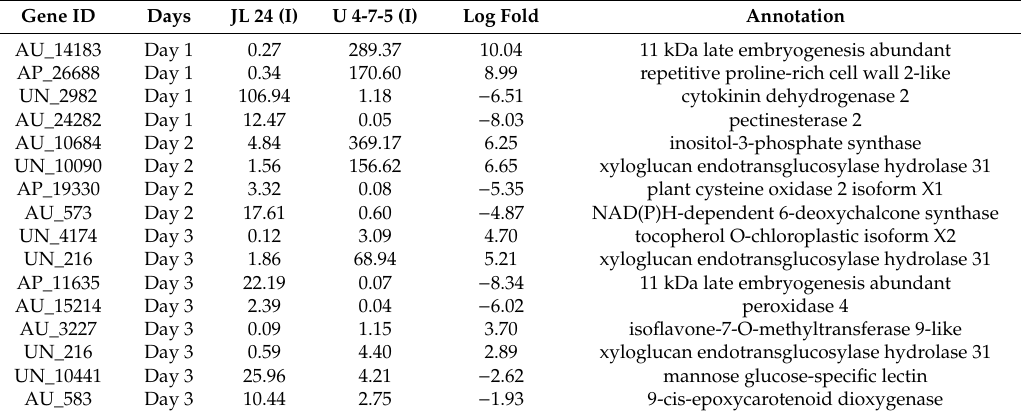
Table 3. Highly di ff erentially expressed putative candidate genes for AP in groundnut identified through transcriptome